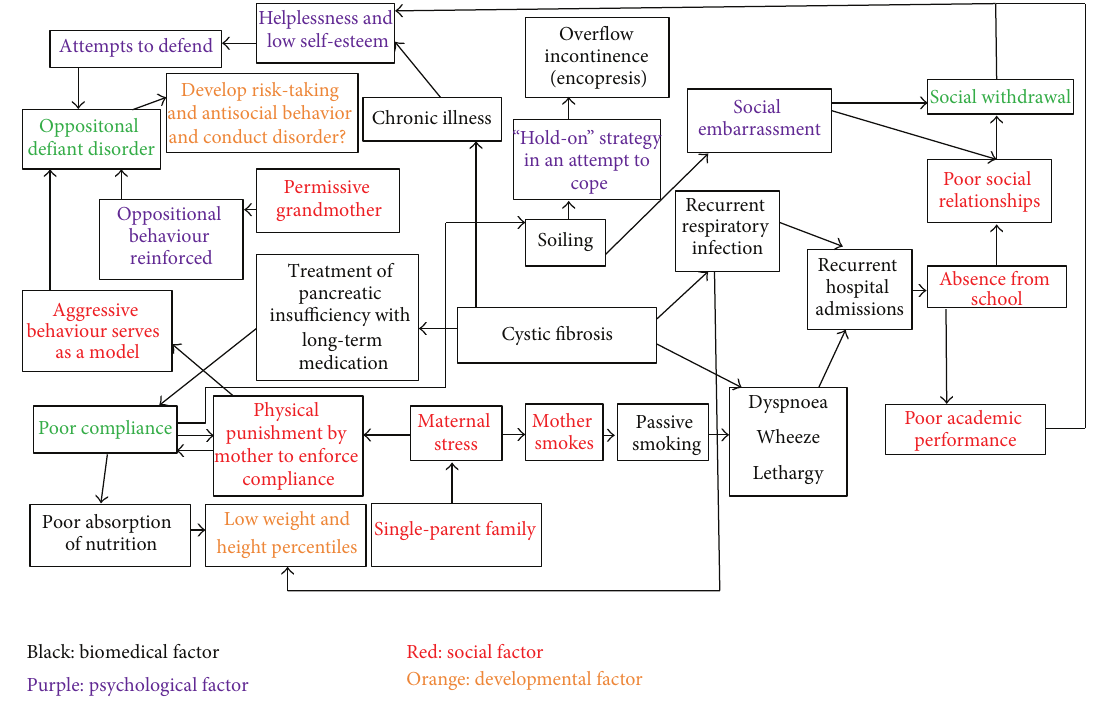
Figure 1: The multifactorial interactions of the disease of